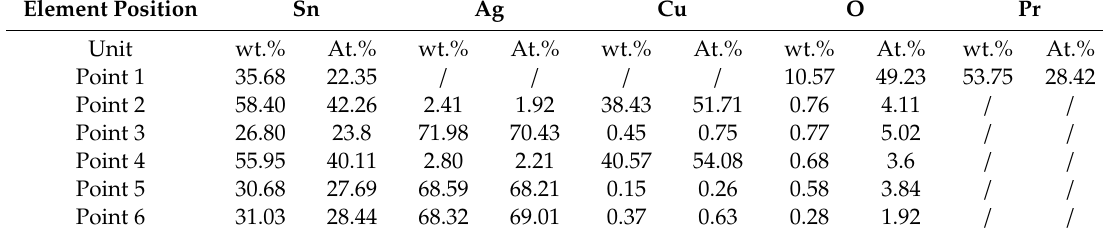
Figure 1. OM Microstructure of ( a ) SAC0307 solder; ( b ) SAC0307-0.05Pr solder; ( c ) aged SAC0307 solder at 150 °C for 840 h; ( d ) aged SAC0307-0.05Pr solder at 150 °C for 840 h, ( e ) SEM image of aged SAC0307-0.05Pr solder at 150 °C for 840 h.